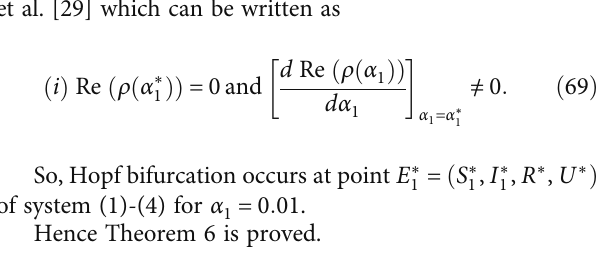
Figure 34: Diagram of Hopf